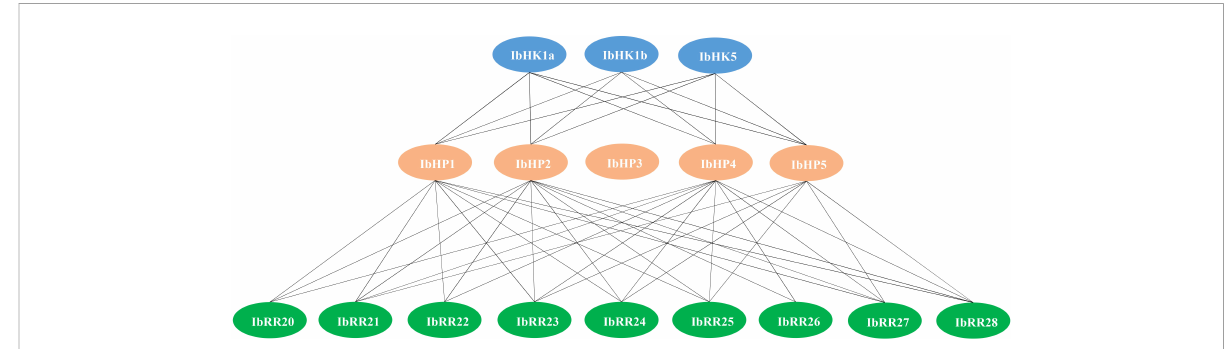
FIGURE 10 Schematic presentation of interacted TCS proteins in Ipomoea batatas . Lines indicate the direct protein-protein Interactions detected with yeast-two hybrid assays in this